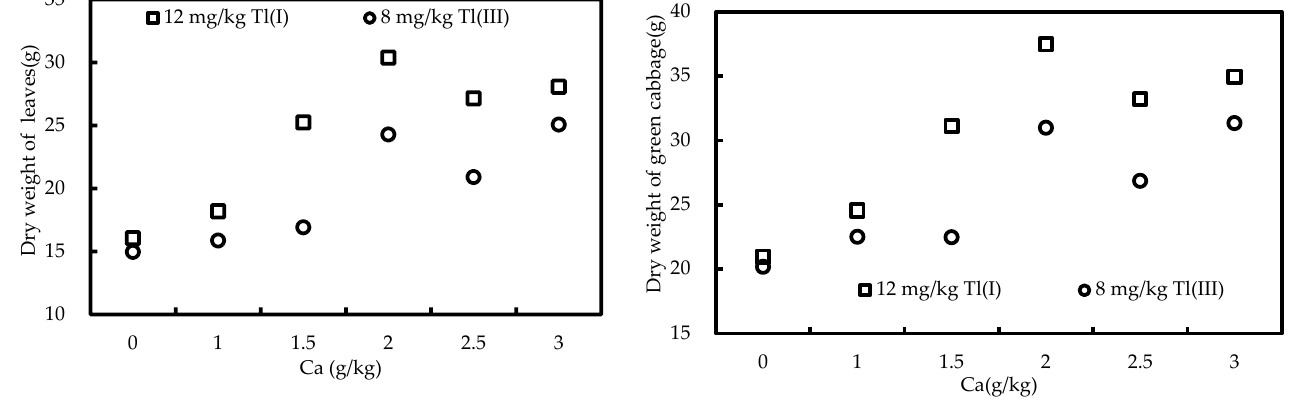
Figure 1. The relationship between the dry weight of plants (leaves, green cabbage) and the spiked Ca. Green cabbage biomass was maximum at the Ca treatment of 2.0 g/kg. There was no significant difference among Ca treatments ( p < 0.05), which may be attributed to the fact that the exchangeable Ca concentration under 2.0 g/kg Ca treatment was saturated in the soil (Figure 2).